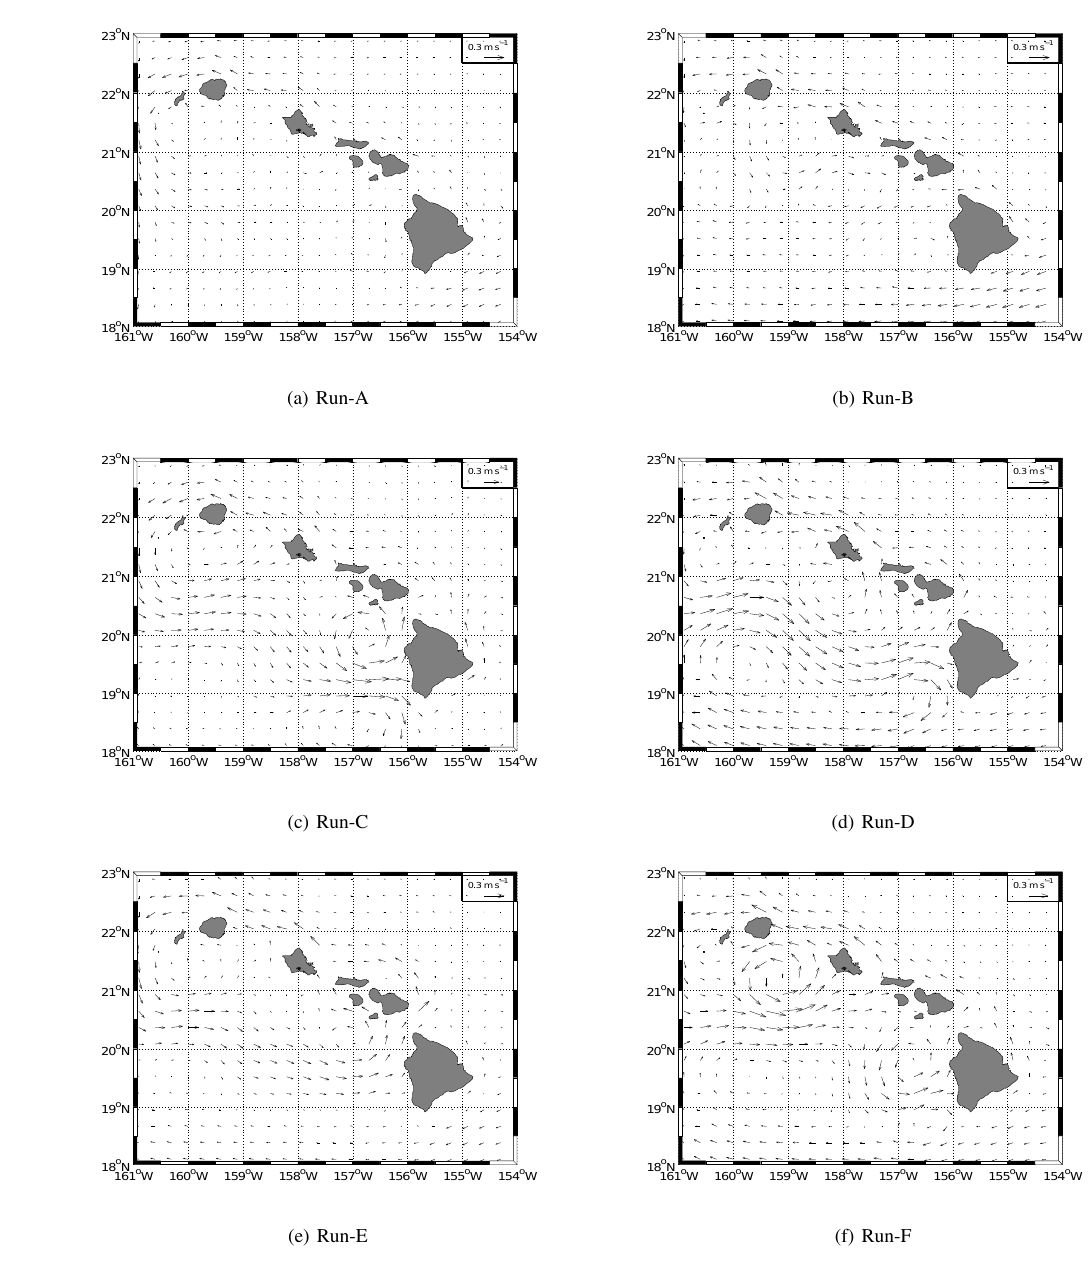
Fig. 3. Annually-averaged currents’ velocity vectors at 40-m depth.